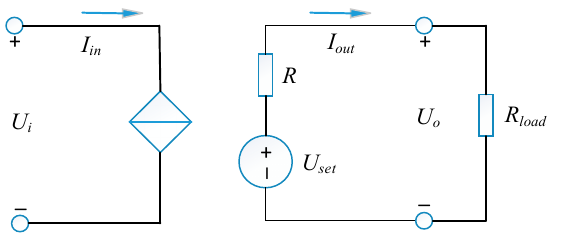
Figure 5. Equivalent circuit model of constant voltage operation mode for the bidirectional direct current (DC)/DC converter.